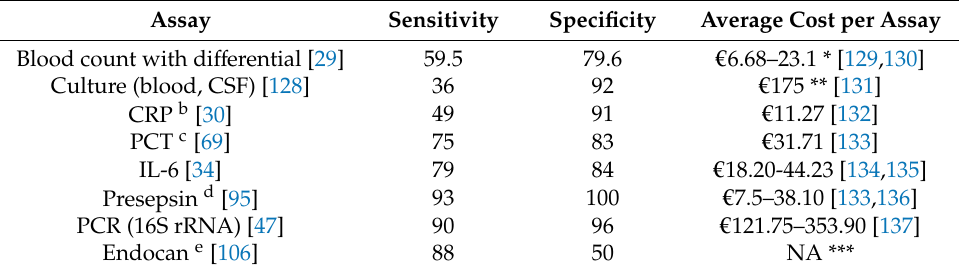
Table 4. Potential panel for EOS